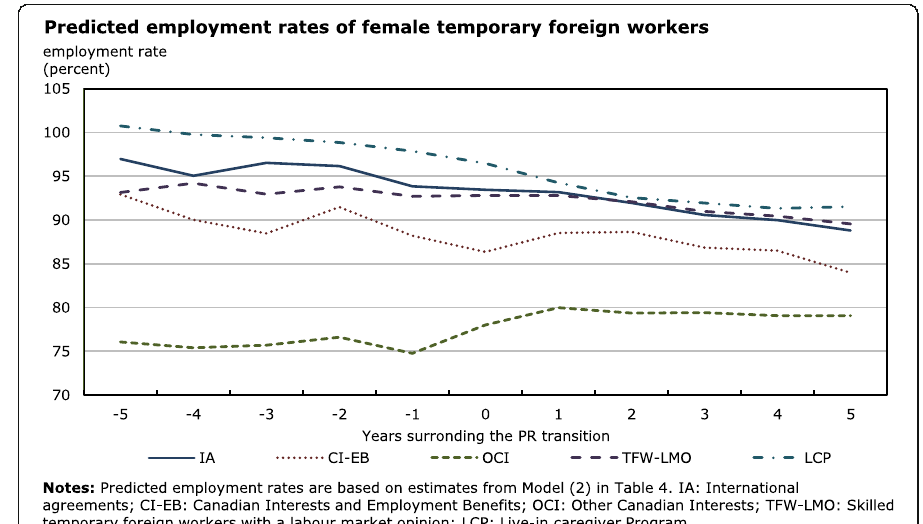
Fig. 6 Predicted employment rates of female temporary foreign workers. Sources: Statistics Canada, Temporary Residents file, Immigrant Landing file and Canadian Employer-Employee Dynamics